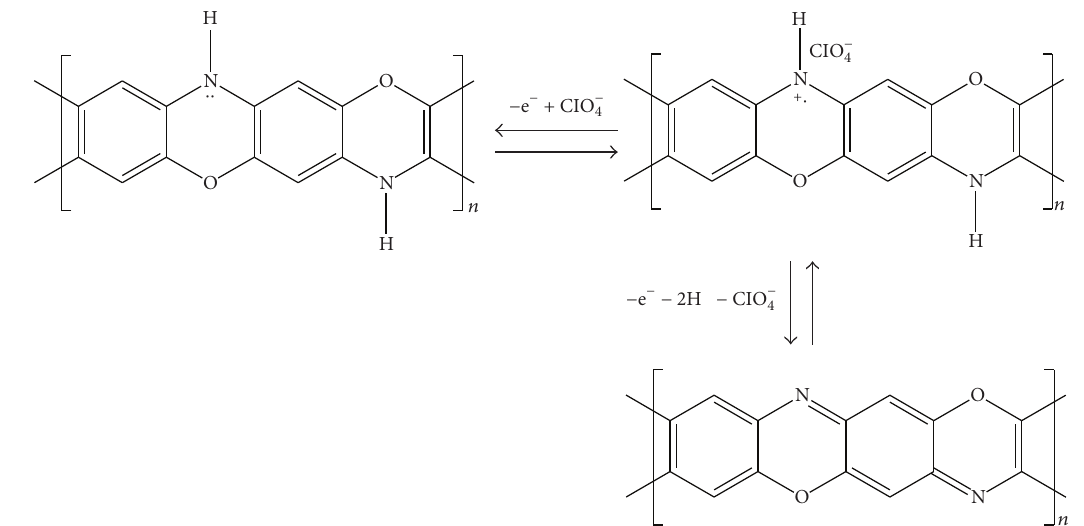
F 18: Reaction scheme for POAP oxidation in acid medium [58].